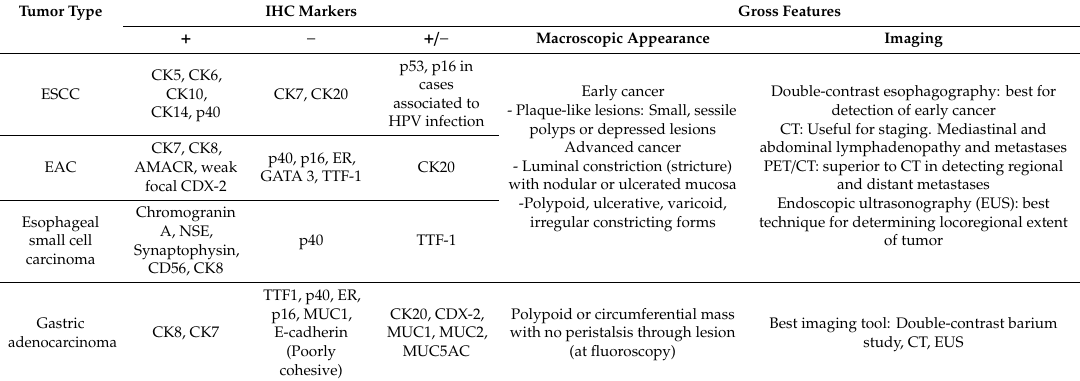
Table 1. A summary of the morphologic and immunohistochemical profiles of upper GI tumors [18–20]. The most common morphologic and immunohistochemical (IHC) traits distinctive of main neoplastic lesions a ff ecting the upper GI tract.